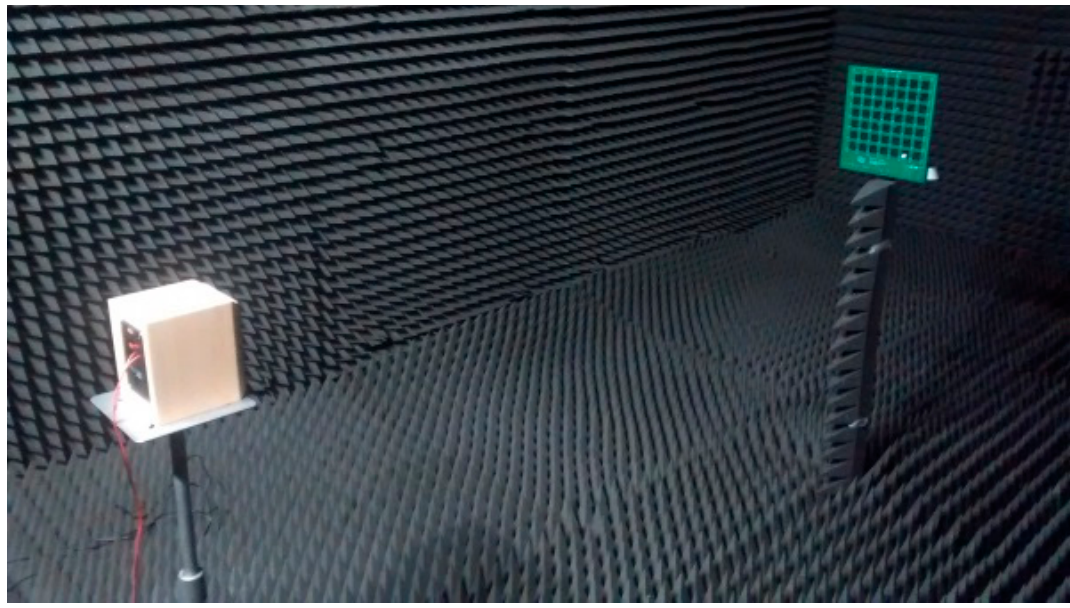
Figure 6. Arrangement of the components in the anechoic chamber.